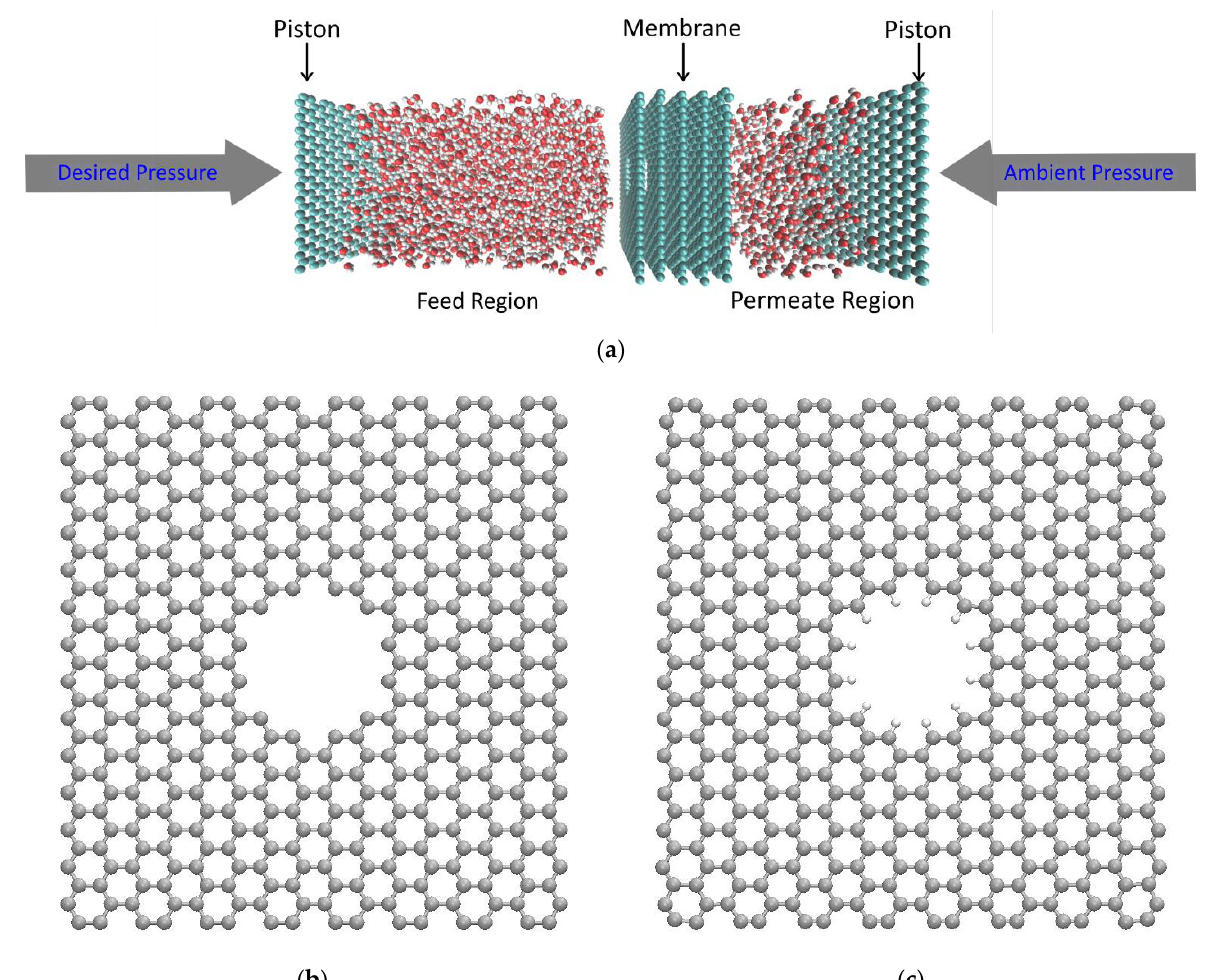
Figure 1. ( a ) Simulation domain, ( b ) porous graphene and ( c ) functionalized (hydrogenated) porous graphene.